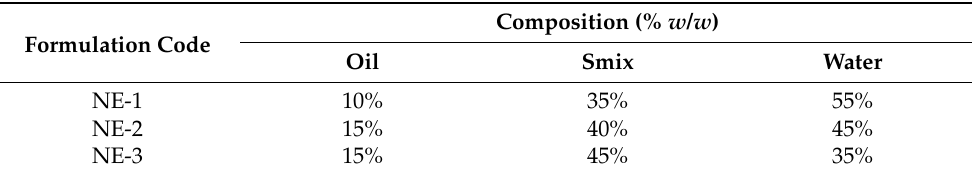
Table 1. Optimum formulae for the preparation of